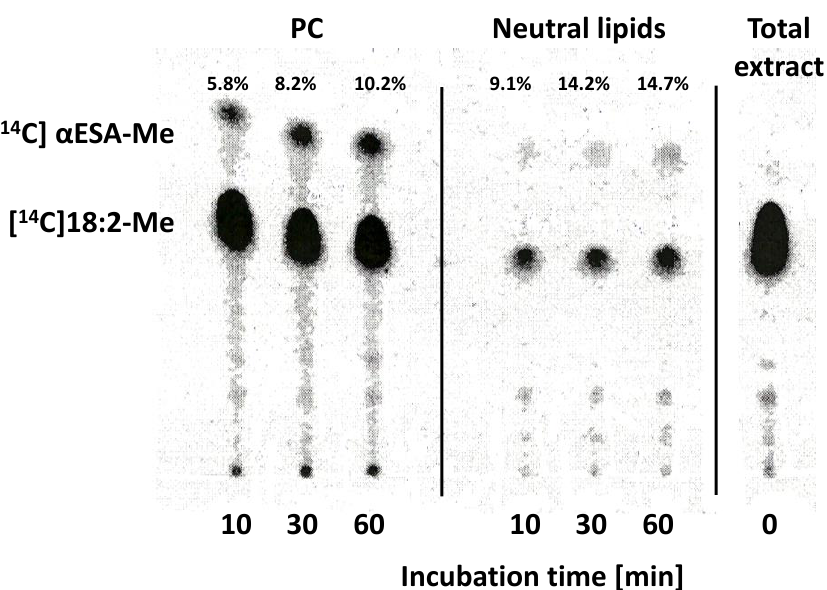
Figure 10. Distribution of [ 14 C]αESA and [ 14 C]18:2 in PC and neutral lipids during incubation of the microsomal fraction of developing seeds of Momordica charantia. Microsomes were pre-incubated for 10 min with [ 14 C]18:2-CoA without NADH (indicated on graph as 0 min incubation time). Afterwards, a new buffer with NADH was added to the pelleted microsomes and incubated for the remaining time. X% = percentage of [ 14 C] in αESA -ME of a given lipid eluted from TLC and after transmethylation separated on TLC impregnated with AgNO 3 (mean values from duplicates).